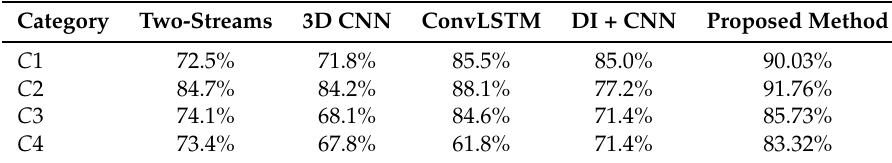
Table 7. Performance comparison of the two-streams, 3DCNN, CNN + RNN (ConvLSTM), DI + CNN methods with the proposed method on the NTU RGB + D action dataset using depth modality and cross-subject protocol.